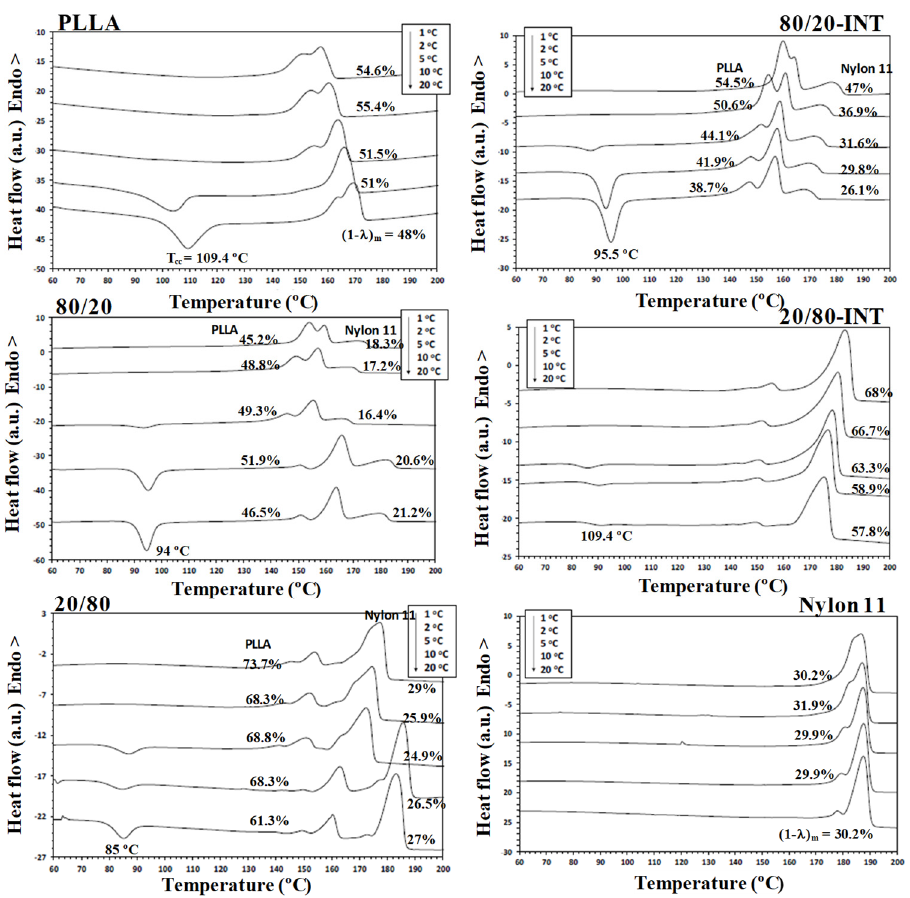
Figure 9. DSC thermograms obtained at a heating rate of 10 °C/min for the PLLA/nylon 11-INT blend nanocomposites after non-isothermal crystallization at the indicated cooling rates.